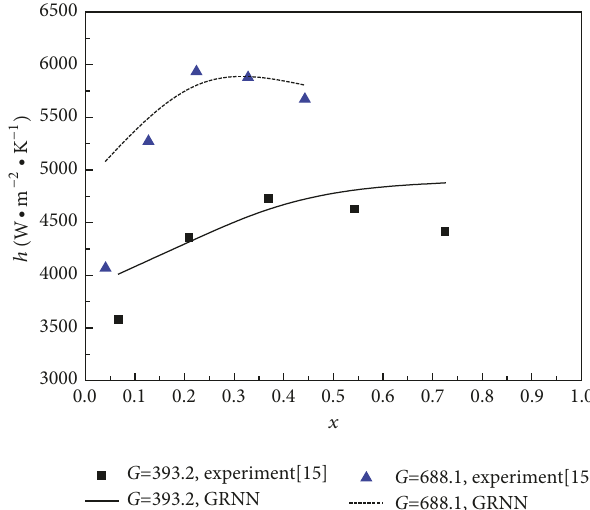
Figure 6: When the evaporation temperature is 50 ∘ C, the heat transfer coefficient of R245fa changes with quality of vapor-liquid mixture and mass flux rate.